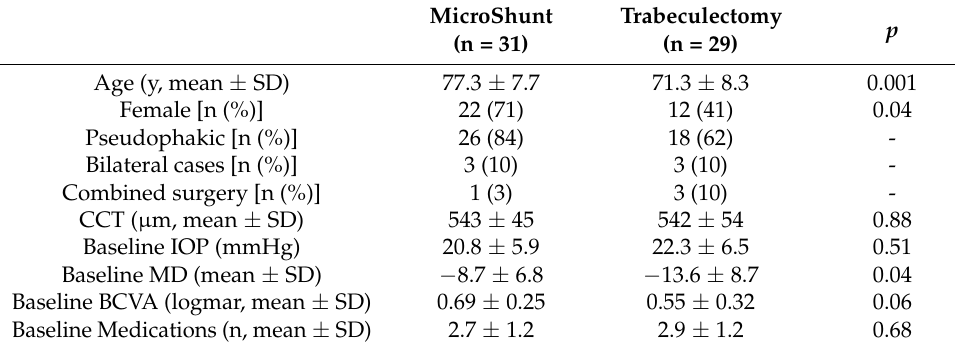
Table 1. Demographic and clinical